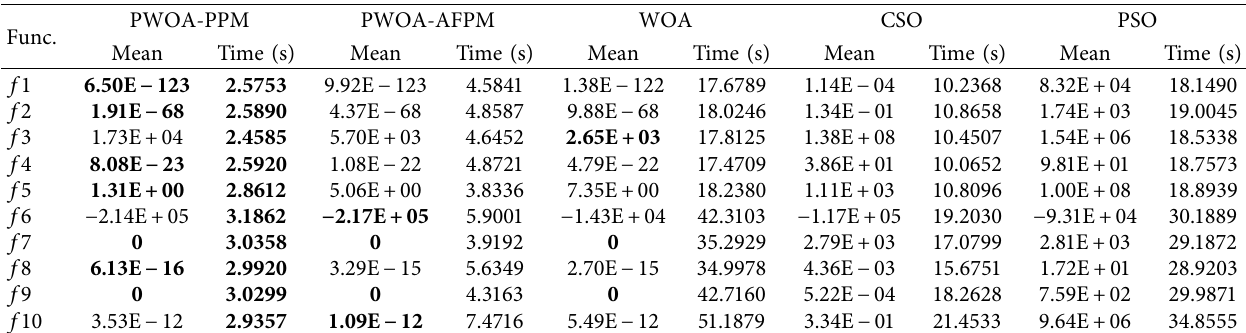
Table 5: Comparison between the proposed algorithms and the state-of-the-art algorithms (512D).